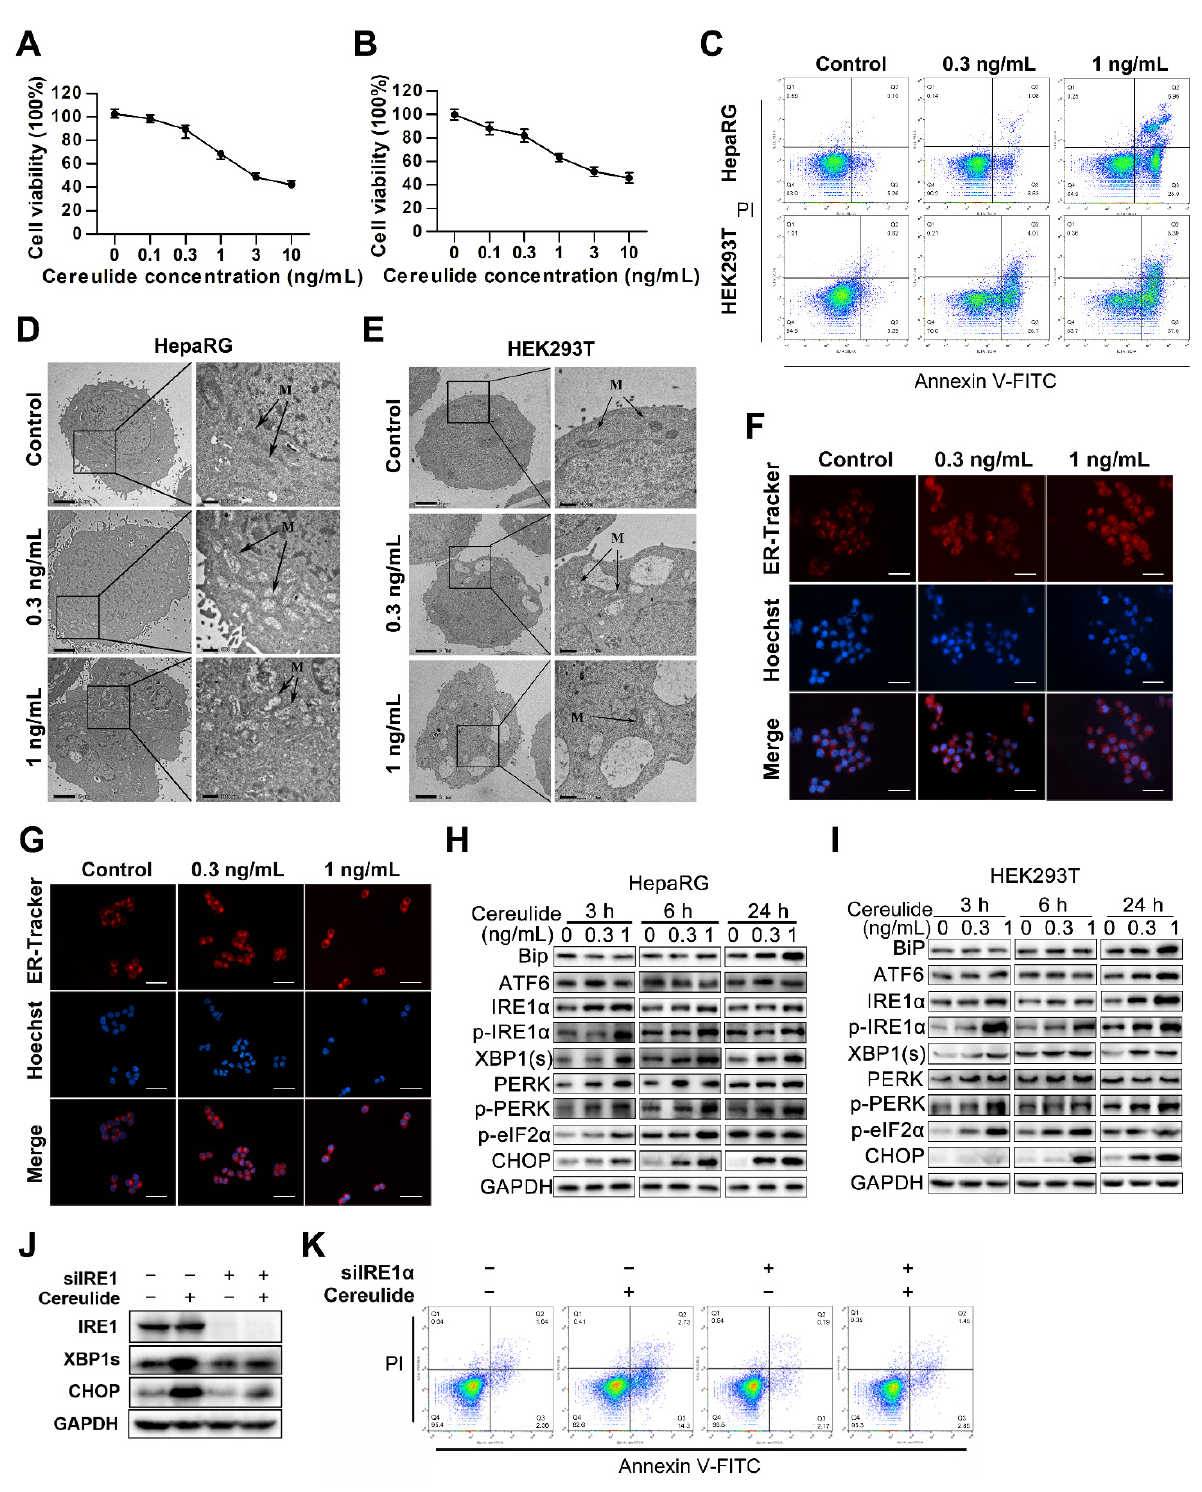
Figure 3. Cereulide triggers apoptosis by mediating ER stress in HEK293T cells and HepaRG cells. ( A , B ) Cytotoxicity of cereulide in HepaRG and HEK293T cells. HepaRG and HEK293T cells were treated with different concentrations of cereulide for 24 h. Cell viability was then determined with CCK-8 ( n = 5). ( C ) Cell apoptosis resulting from cereulide treatment in HepaRG and HEK293T cells. HepaRG and HEK293T cells were evaluated with 0.3 and 1 ng/mL cereulide by flow cytometry. The data were analyzed using FlowJo software ( n = 3). ( D , E ) Representative transmission electron microscopy images of HepaRG and HEK293T cells treated with cereulide toxin. Cereulide treated HepaRG and HEK293T cells for 24 h, and observed by transmission electron microscope. M indicates mitochondria. Scale bars: left panel, 2 μ m;